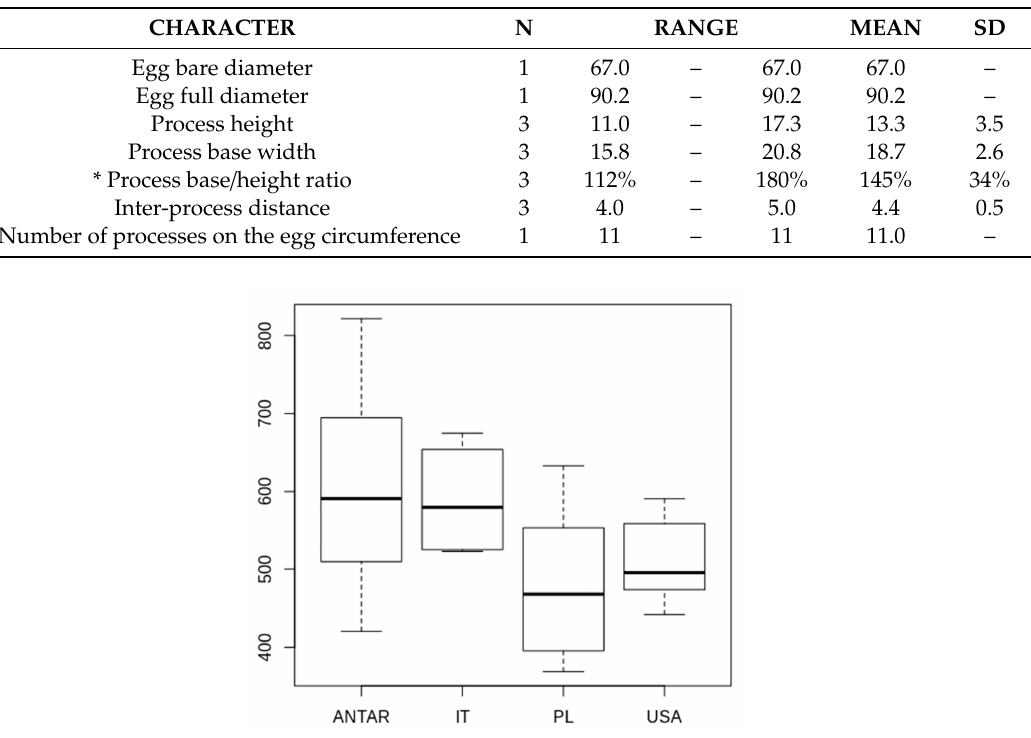
Figure 4. Differences in the body length (in micrometres ( μ m)) between the studied populations of Paramacrobiotus fairbanksi Schill, Förster, Dandekar and Wolf [25] (Antar, Antarctic; IT, Italy; PL, Poland; USA, USA). Minimum, maximum, median, first quartile, and third quartile for each population are presented.